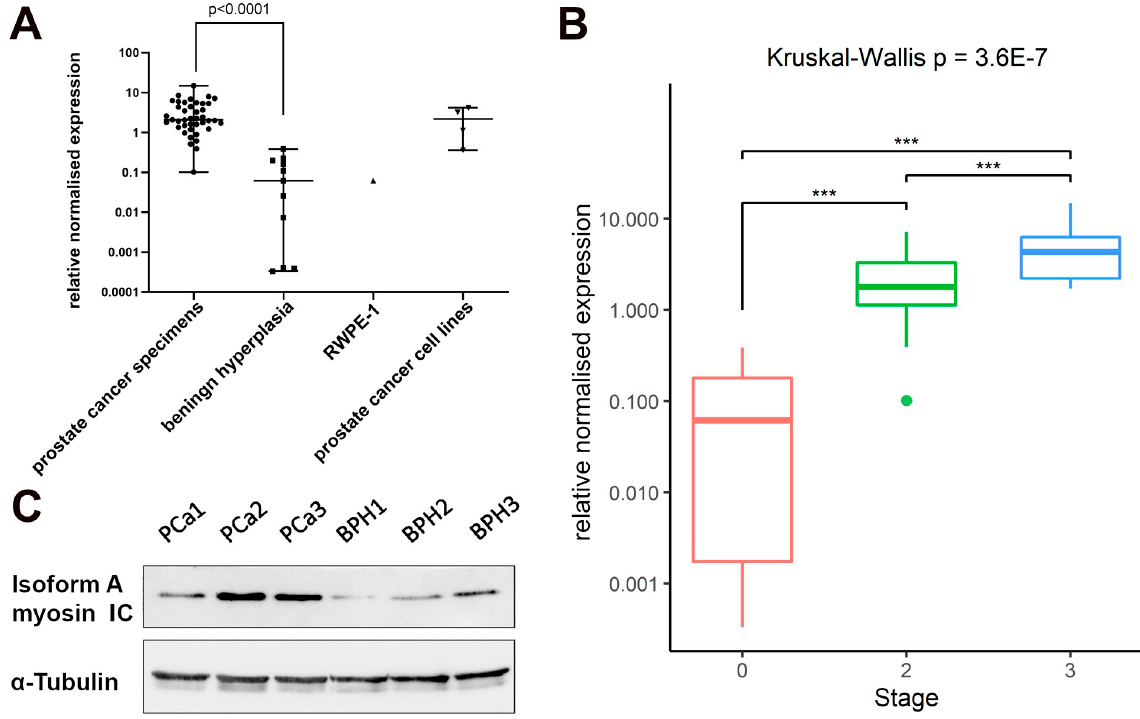
Fig 1. Myosin 1C isoform A is overexpressed in prostate cancer specimens on mRNA and protein level. A–relative normalized mRNA quantity in clinical BPH and PCa specimens and prostate cell lines. Horizontal lines represent range and median; all experiments were conducted in triplicate and the results normalized to YWHAZ, GAPDH, and HPRT1 genes. B—Box plot of myosin 1C isoform A levels at different disease stages. Pairwise comparison of means is indicated with p-values obtained in Conover-Iman post-hoc test with Holm correction. Data shown with median values (thick horizontal line), interquartile ranges (boxes), total ranges (whiskers), and outliers (dots). C– Immunoblotting of myosin 1C isoform A in prostate cancer samples (PCa1-PCa3) and benign prostate hyperplasia samples (BPH1-BPH3). Alpha tubulin was taken as technical control.